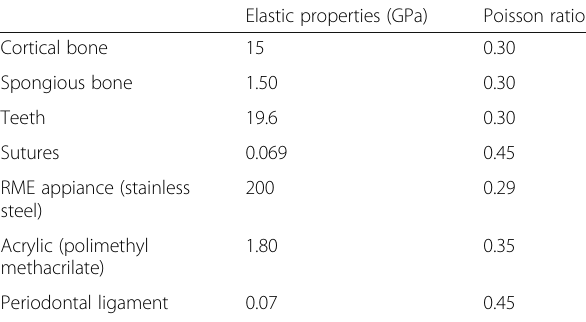
Table 1 Elastic properties and Poisson ratio ’ s of the structures used in the study Elastic properties (GPa)